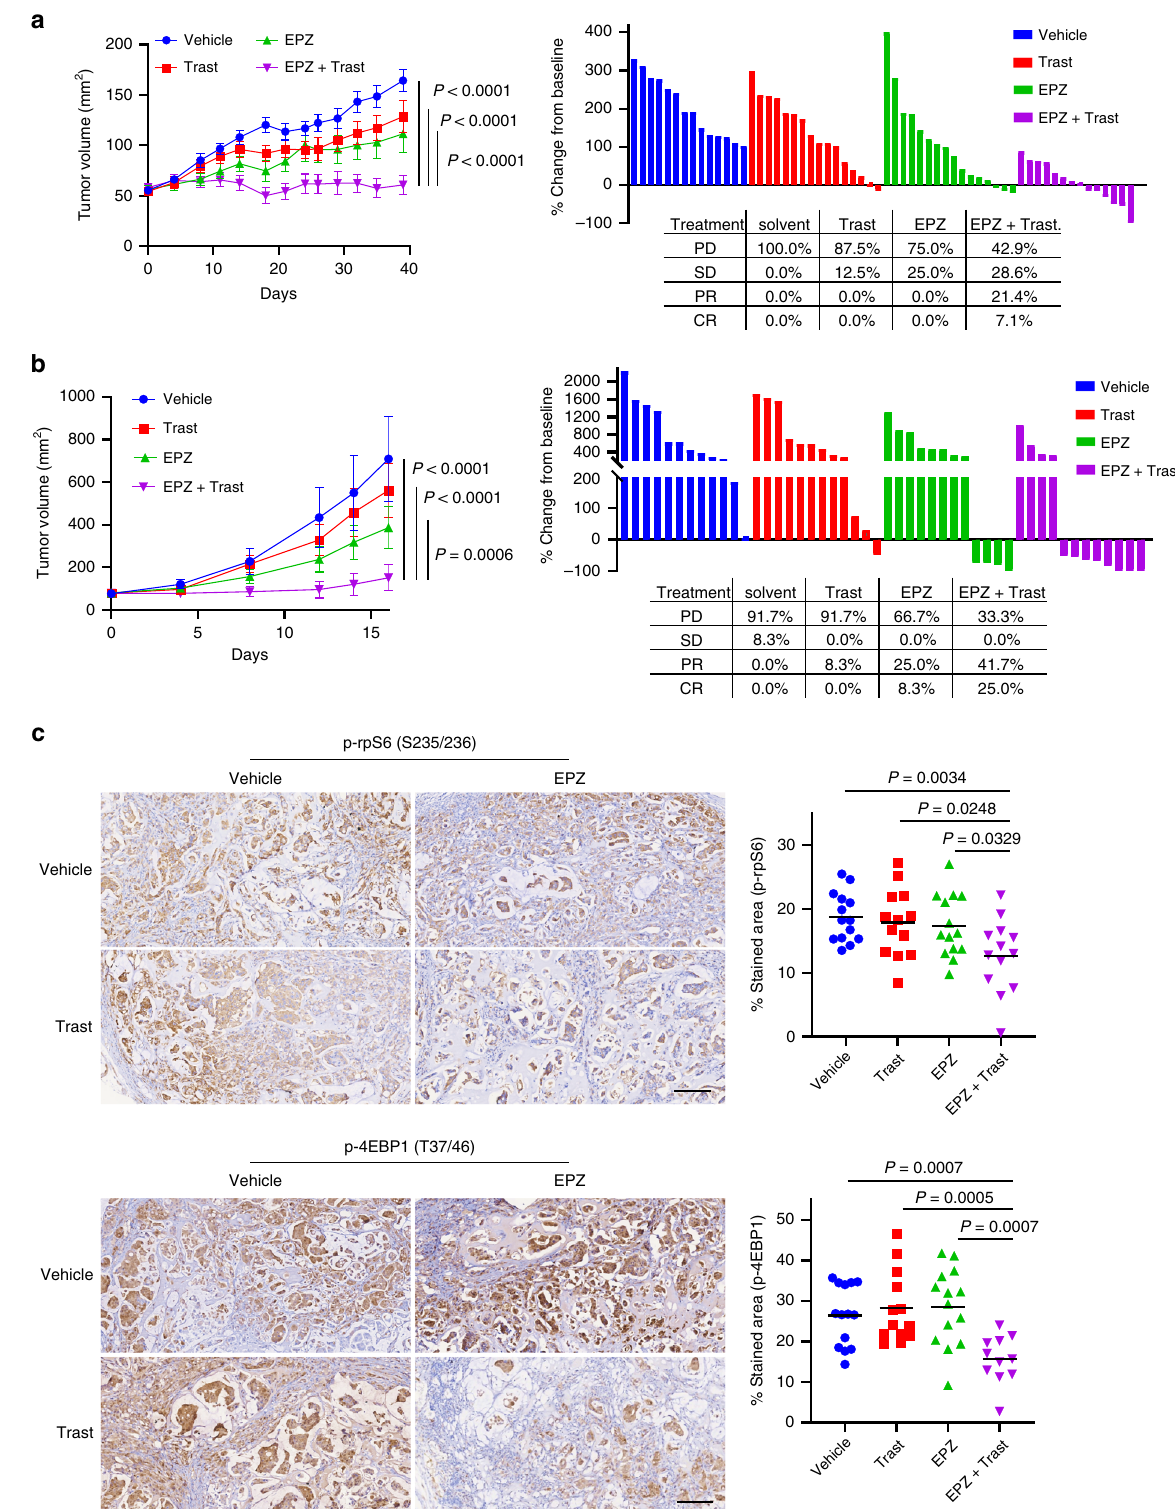
lapatinib-resistant cell line is denoted as BT474LR (Fig. 7a), and the trastuzumab-resistant cell line is denoted as BT474TR (Fig. 7b). As expected, the expression of PPP2R2B , but not the other PP2A subunits, showed marked downregulation in both BT474LR and BT474TR cells compared to parental BT474 cells (Fig. 7c). Accordingly, forced expression of PPP2R2B in the NATURE COMMUNICATIONS| (2020) 11:5878